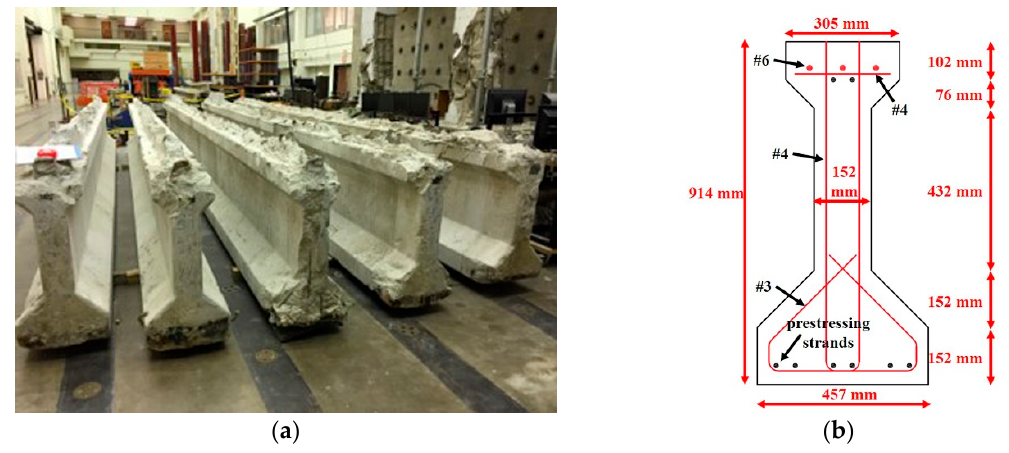
Figure 2. AASHTO Type II PC girders: ( a ) full-scale PC girder and ( b ) section details.